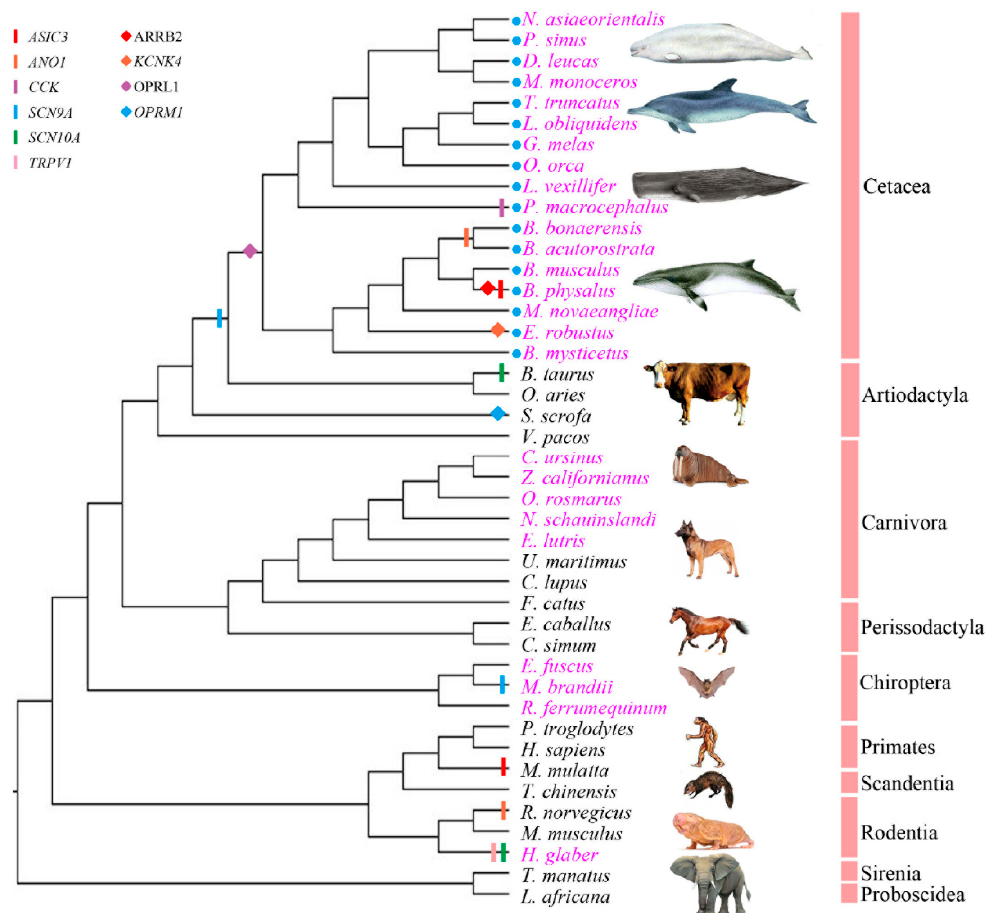
Figure 2. Positive selection detected in the mammalian dataset using the branch-site model. Blue circles represent cetacean species. Reported pain-adapted species are shown in purplish red font; unreported pain-adapted species are shown in black font. The lineages for which positive selection was detected on pain perception genes are shown with vertical bars of different colors: ASIC3 (red), ANO1 (orange), CCK (purple), SCN9A (blue), SCN10A (green), TRPV1 (pink). The branches for which positive selection was detected on analgesia genes are indicated by diamonds of different colors: ARRB2 (red), KCNK4 (orange), OPRL1 (purple), OPRM1 (blue).